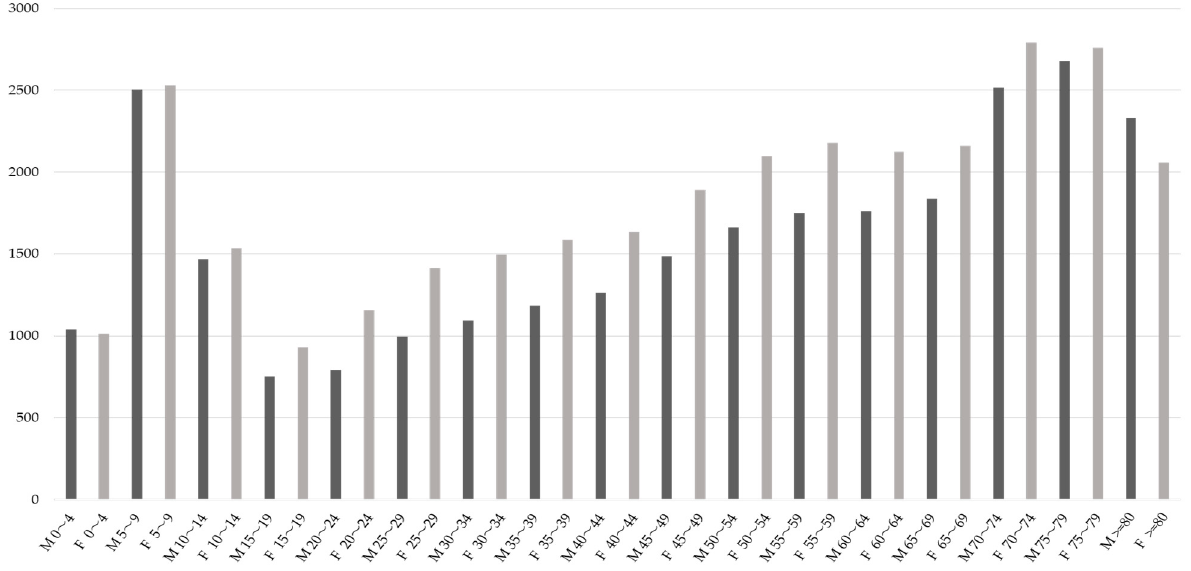
Figure 1. The number of age-specific dental receipts per 1000 people by gender in FY2018. M: male, F: female.